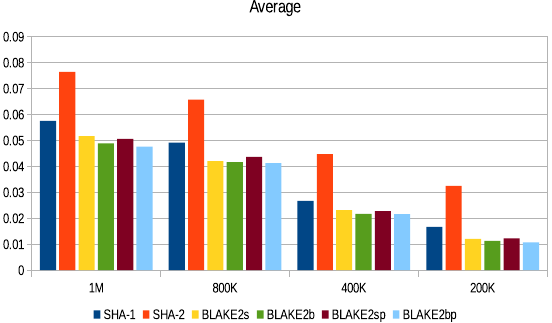
Figure 21. Average execution time of hash functions with different data sizes.